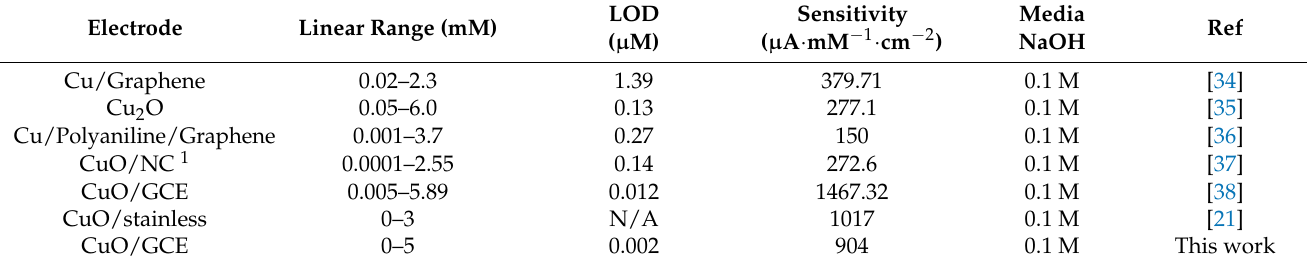
Table 1. Copper and copper oxide-based electrodes for glucose